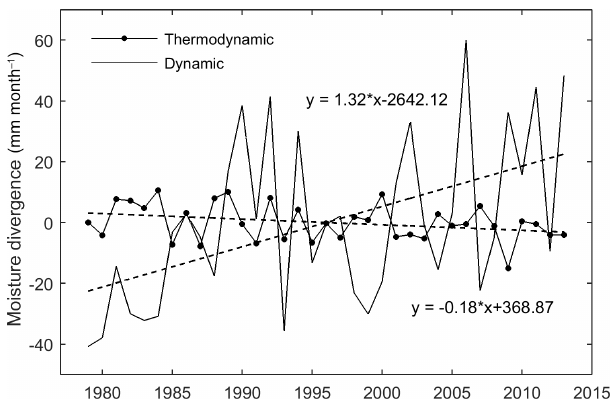
Figure 6. The anomalies of moisture divergence over JAS SWC (unit: mmmonth − 1 ) caused by thermodynamic and dynamic terms during 1979–2013.